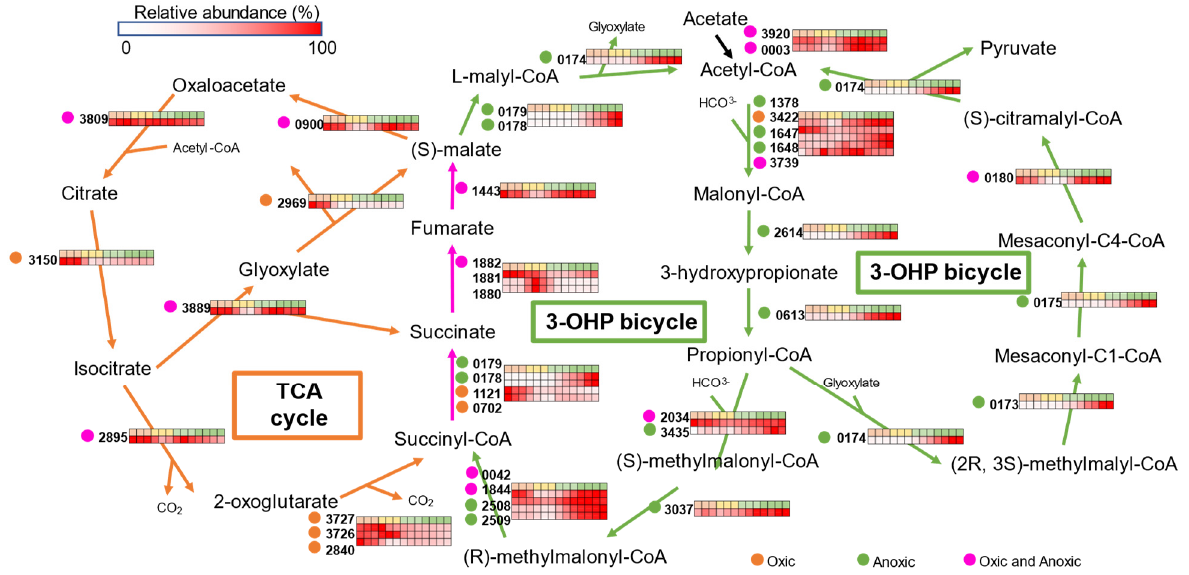
Figure 4. The heatmap showing the relative abundance of each protein involved in central carbon metabolisms in C. aurantiacus . The first row on the heat map corresponds to the number of cultivation days: orange, days 0–5; yellow, days 6–10; light green, days 12–17; dark green, days 20–39. Arrows indicate the enzymatic reactions for relevant metabolisms: orange, TCA cycle; green, 3-OHP bi-cycle; pink, both TCA and 3-OHP. Four-digit numbers on the left of heat maps represent locus tag numbers of C . aurantiacus genes.